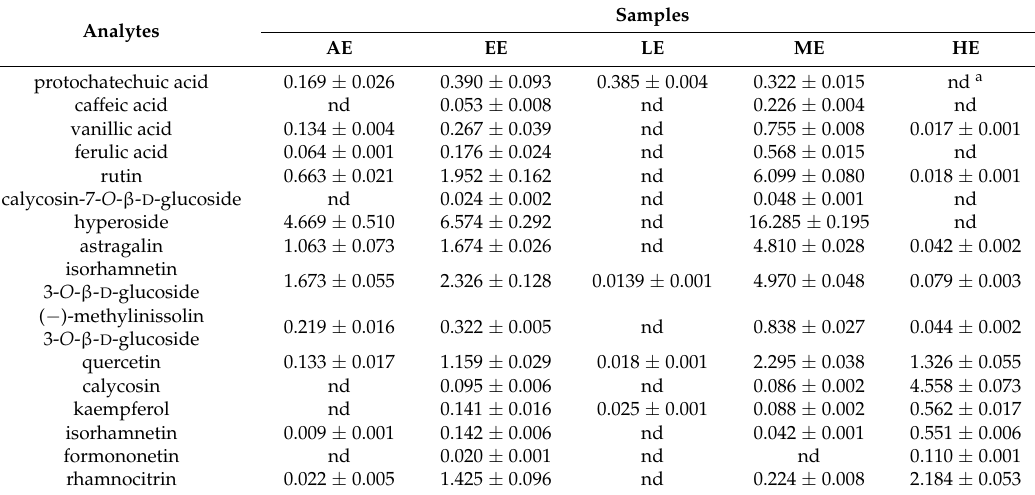
Table 5. The contents (mg/g) of 16 investigated compounds in extracts of AMF.